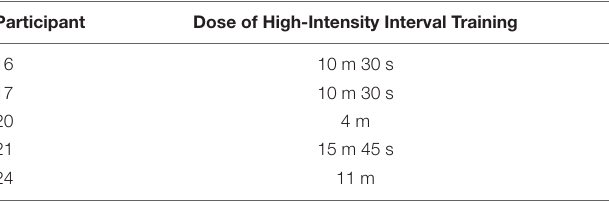
TABLE 2 | Dosage for participants who did not complete the high-intensity interval